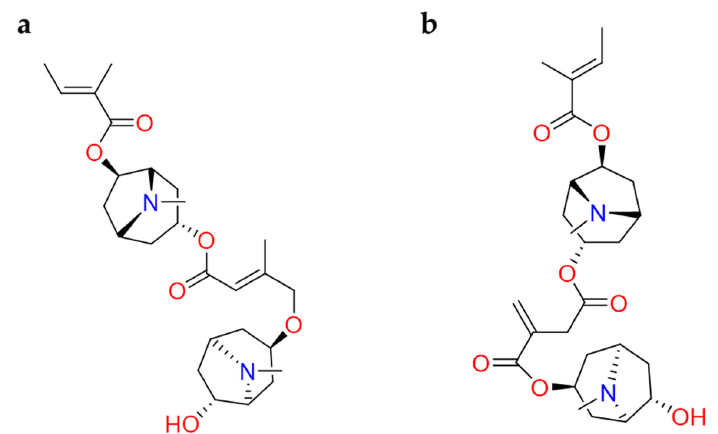
Figure 13. 2D structures of ( a ) schizanthine Z and ( b ) schizanthine Y.